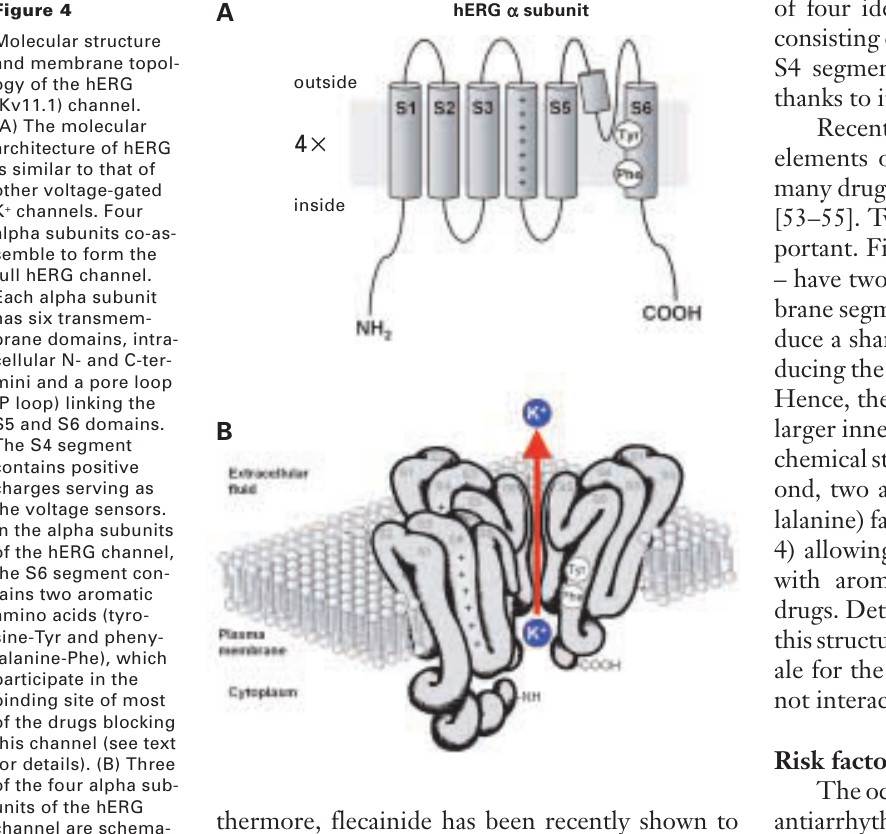
Molecular structure and membrane topol- ogy of the hERG (Kv11.1) channel.